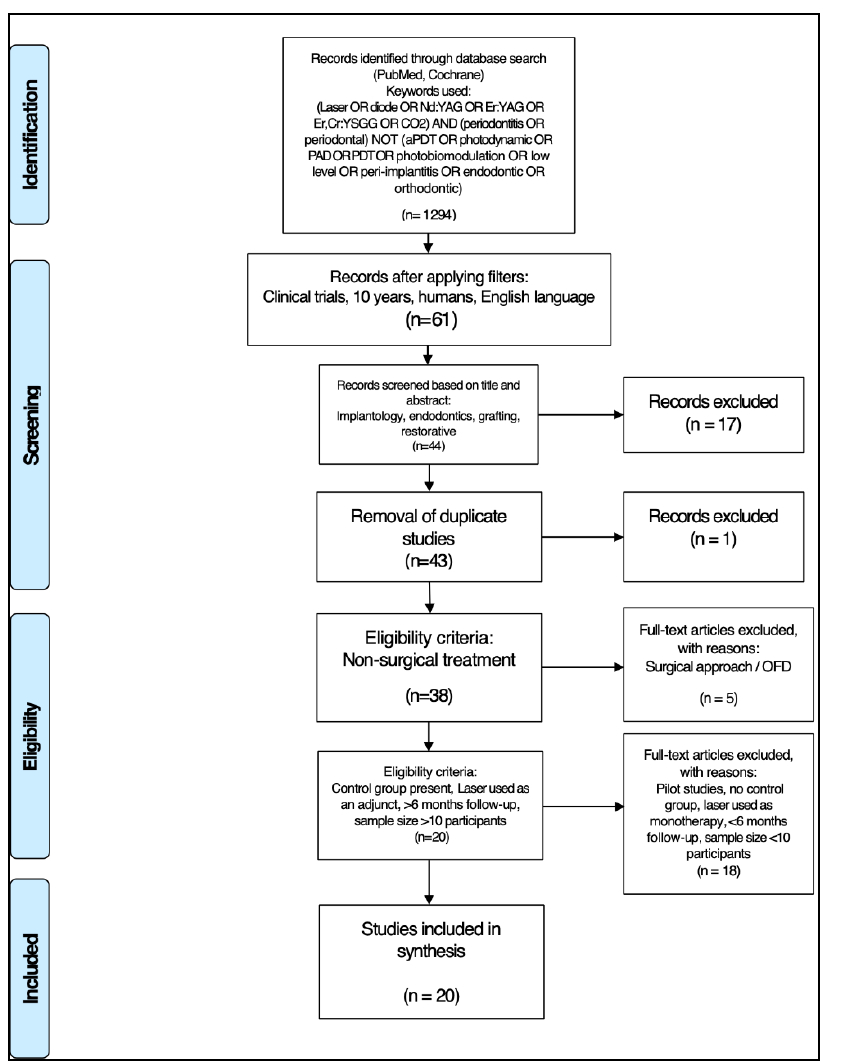
Figure 1. PRISMA flow-chart of selection criteria to determine article inclusion.